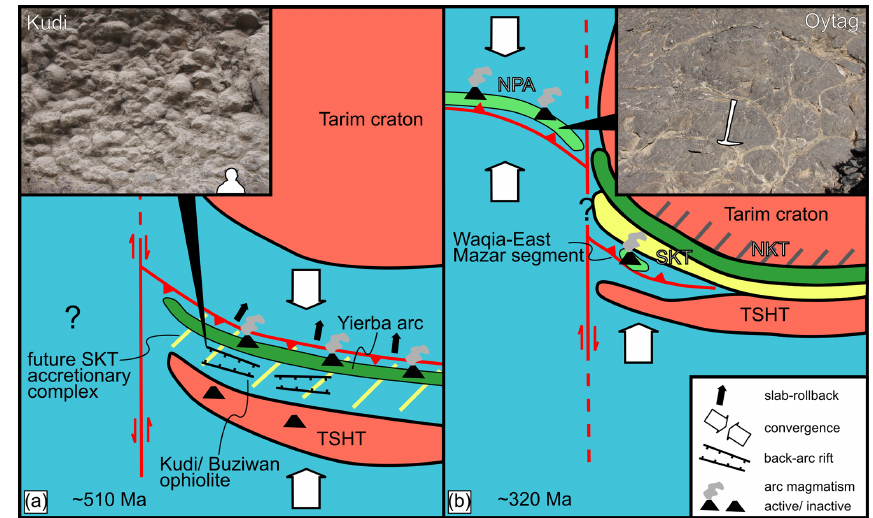
Figure 9. (a) Paleogeographic situation in the mid-Cambrian: the roll-back of the Proto-Tethys slab caused the formation of the Kudi ophiolite, exposed in the Buziwan valley (Wang et al., 2021). (b) Paleogeographic situation in the late Mississippian: the North Pamir arc formed along an intra-oceanic subduction zone (Jiang et al., 2008) forming the Oytag segment in its eastern branch. Subduction-related Waqia granite (Tang et al., 2020) and East Mazar granite (Li et al., 2006), both today part of tectonic slivers, suggest the presence of a remnant oceanic basin between Tianshuihai and the South Kunlun Terrane accretionary complex, as suggested by Zhang et al. (2018). Small photographs show pillow basalts in the Kudi section (in a ) and Oytag near Qimgan (in b ). SKT – South Kunlun Terrane, TSHT – Tianshuihai Terrane, NPA – North Pamir volcanic arc, NKT – North Kunlun